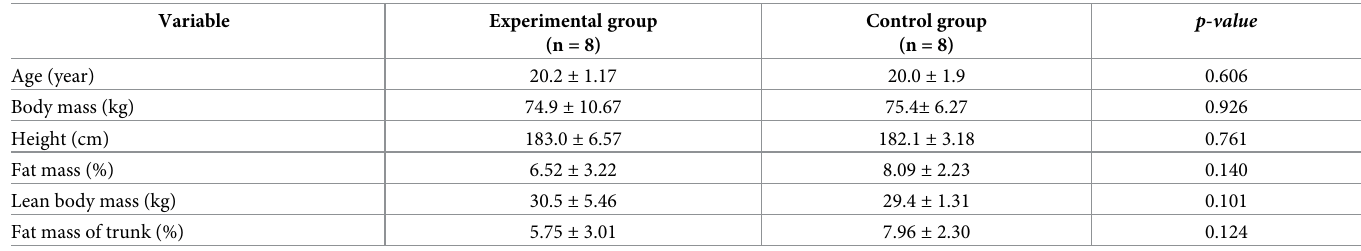
Table 1. Physical characteristics of participants (mean ±